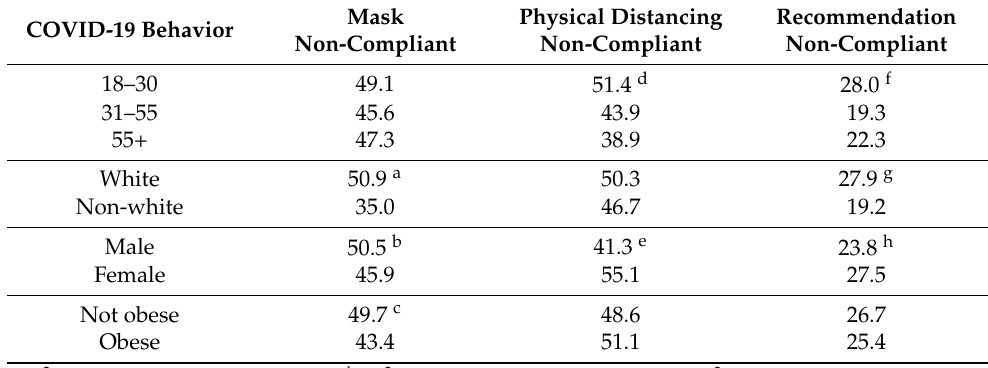
Table 3. COVID-19 behaviors among physically active individuals by personal